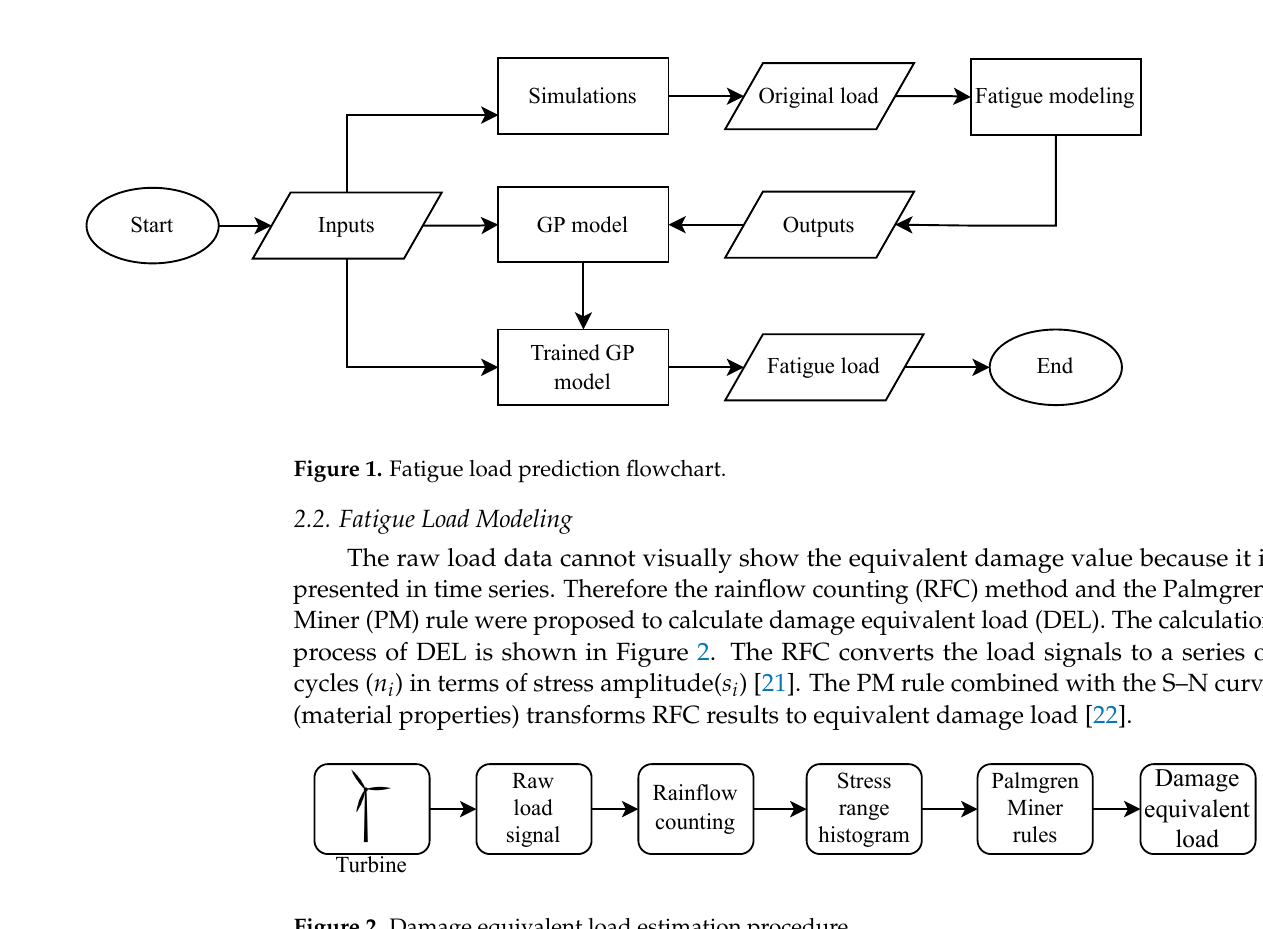
Figure 2. Damage equivalent load estimation